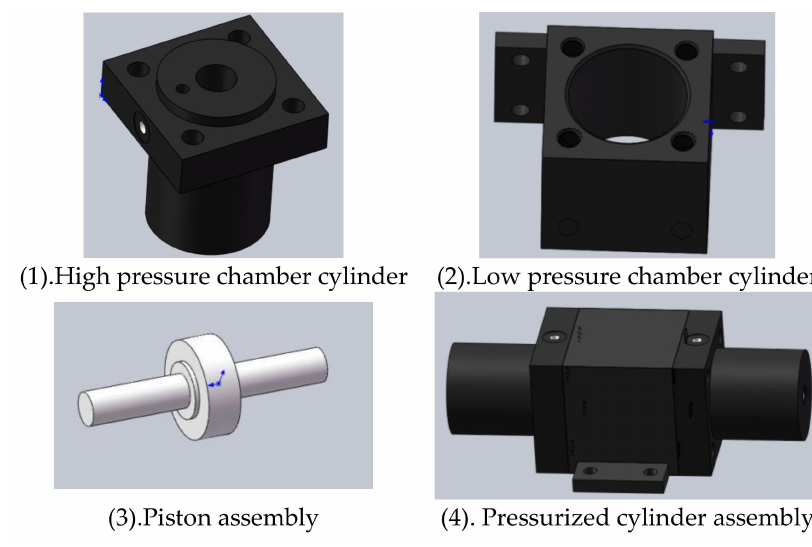
Figure 7. 3D modeling of the pressurized